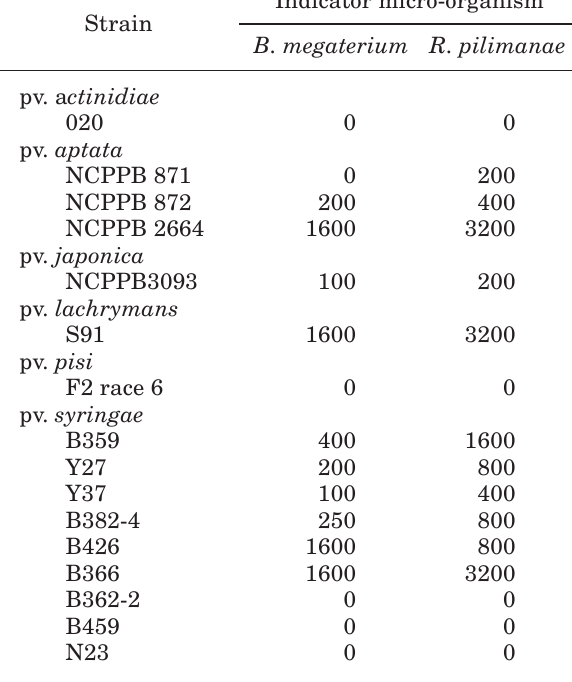
Table 4. Antimicrobial activity, expressed as arbitrary units (AU ml -1 ), against Bacillus megaterium and Rho- dotorula pilimanae , produced by acetone extract solu- tions of 16 strains of 5 Pseudomonas syringae patho- vars grown in modified IMM liquid medium.